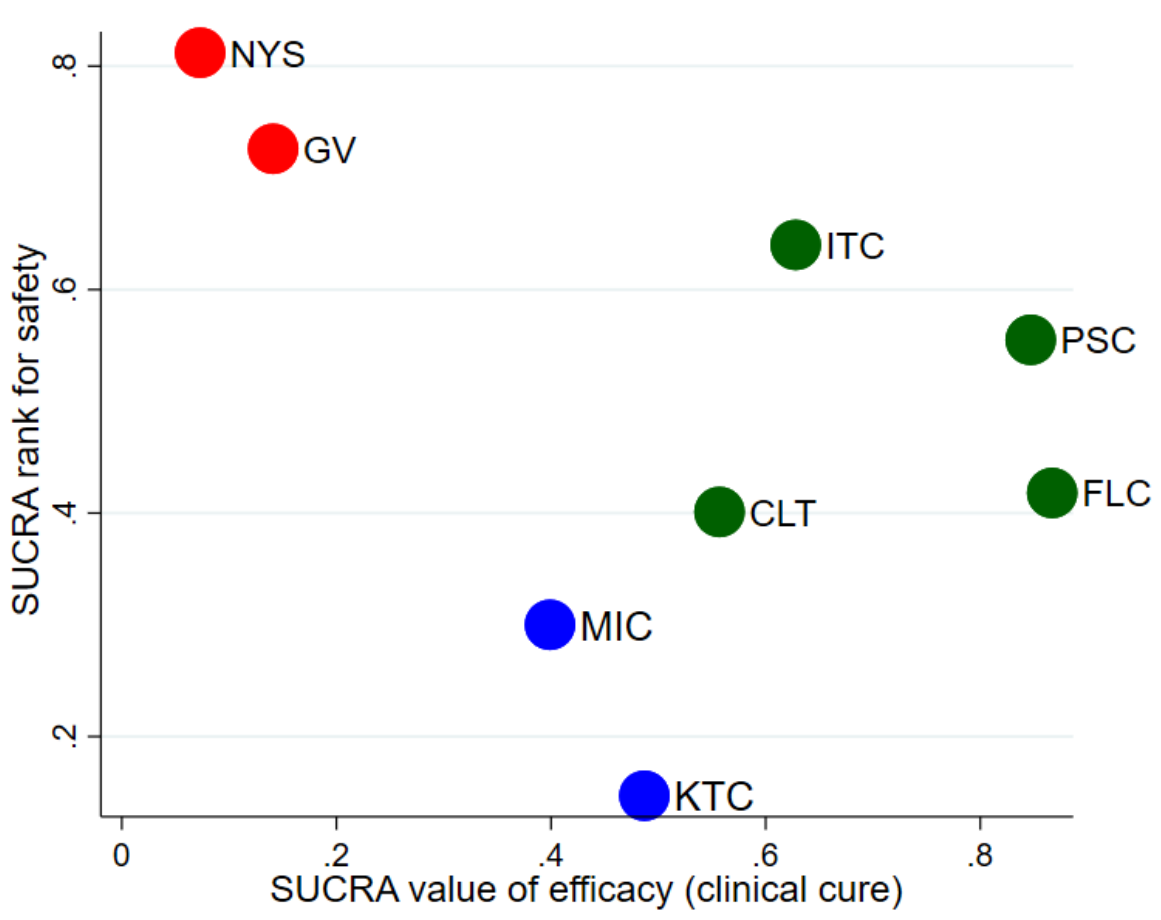
Figure 11. Cluster plot for SUCRA rankings for combined efficacy and safety outcomes. Notes: for efficacy outcomes, lower score indicates better treatment in preventing oral candidiasis. For safety outcomes, lower score indicates safer treatment with lower risk of adverse events. Interventions that are located at left lower site are the most effective and safest in preventing oral candidiasis. Abbreviations: CLT—clotrimazole, FLC—fluconazole, GV—gentian violet, ITC—itraconazole, KTC—ketoconazole, MIC—miconazole, NYS—nystatin, PSC — posaconazole.